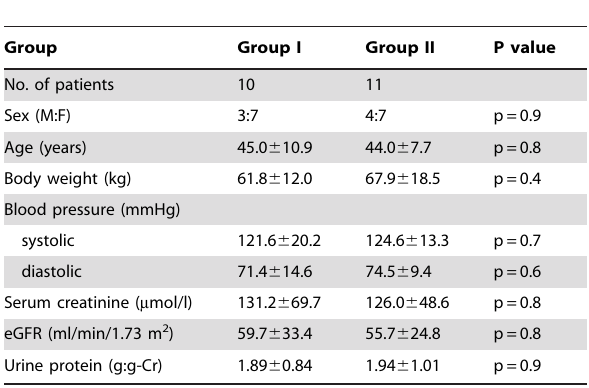
Table 1. Baseline characteristics of the recruited